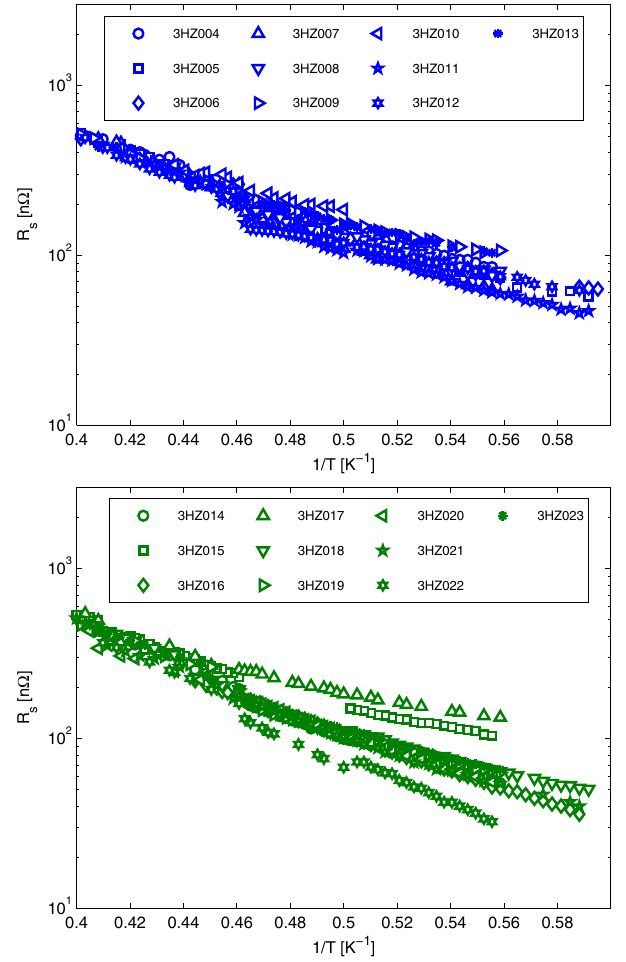
FIG. 12. Surface resistance values for all cavities as a function of T − 1 . First batch (top): cavity serial numbers from 3HZ004 to 3HZ013, second batch (bottom): cavity serial numbers from 3HZ014 to 3HZ023.